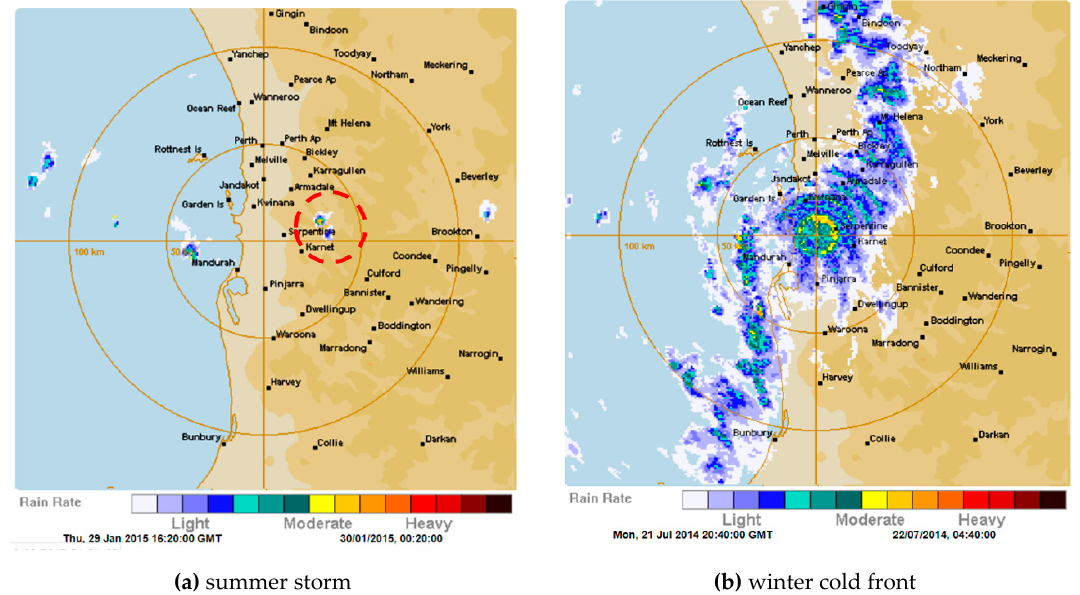
Figure 5. Examples of rainfall events from the Perth region viewed in the Bureau of Meteorology (BOM) rain radar for Perth [18] for ( a ) a localised and intense summer storm event in January (highlighted in red), and ( b ) the storm front of a winter thunderstorm in July.